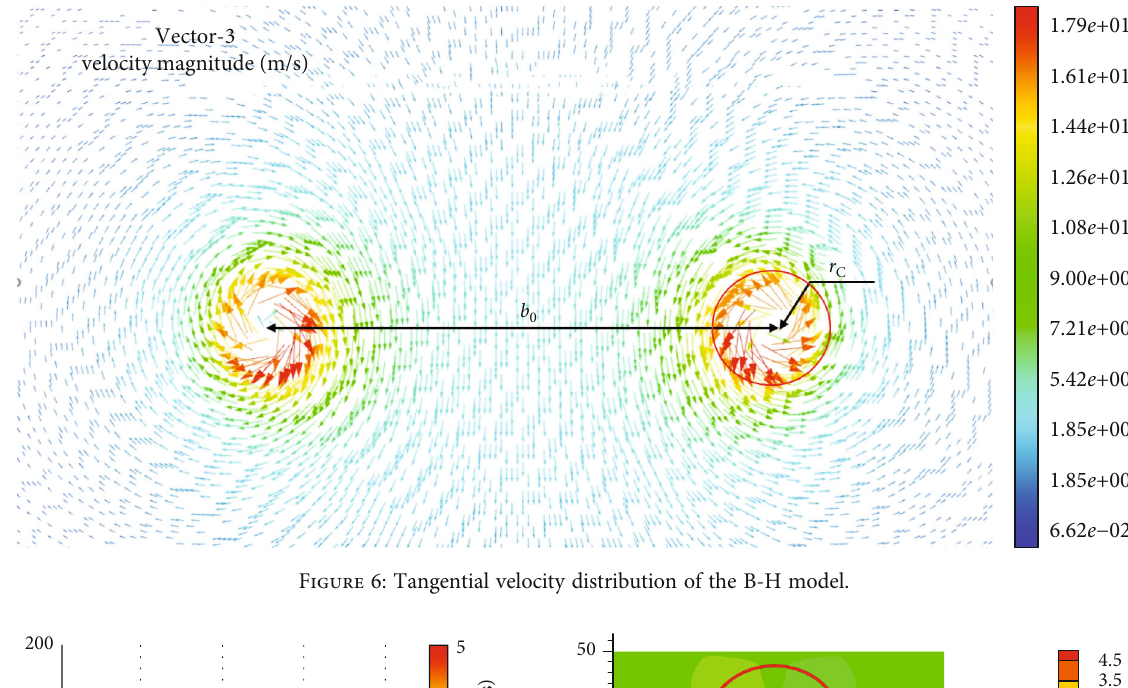
Figure 6: Tangential velocity distribution of the B-H model.